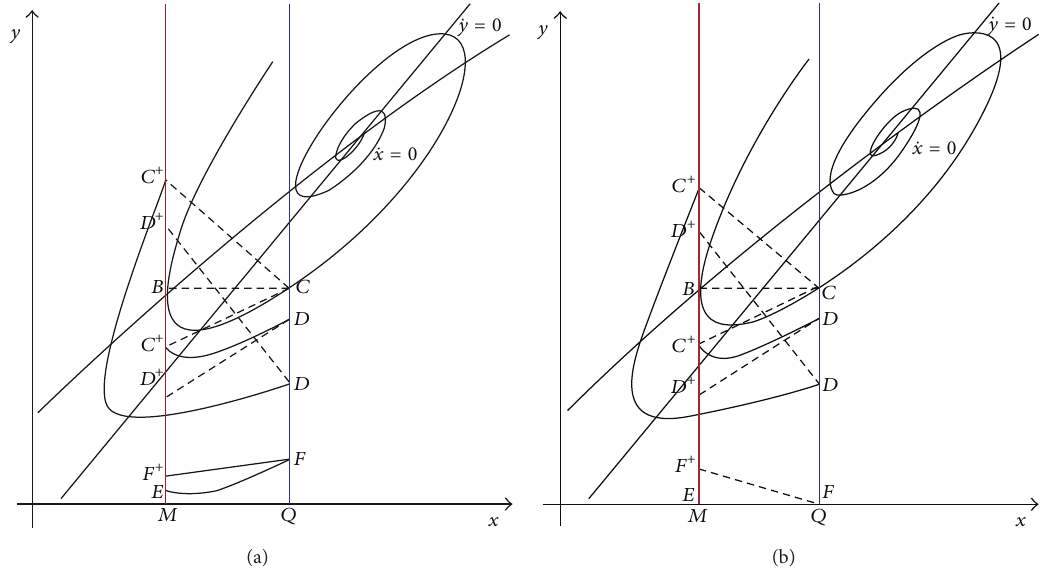
Figure 2: (a) is the proof on Theorem 12; (b) is the proof on Theorem 13. In (a) and (b), the red line 𝑀 and the blue line 𝑄 represent impulsive set and phase set, respectively. The black cure, ̇𝑥 = 0 , denotes vertical isocline, and the black cure, ̇𝑦 = 0 , denotes horizontal